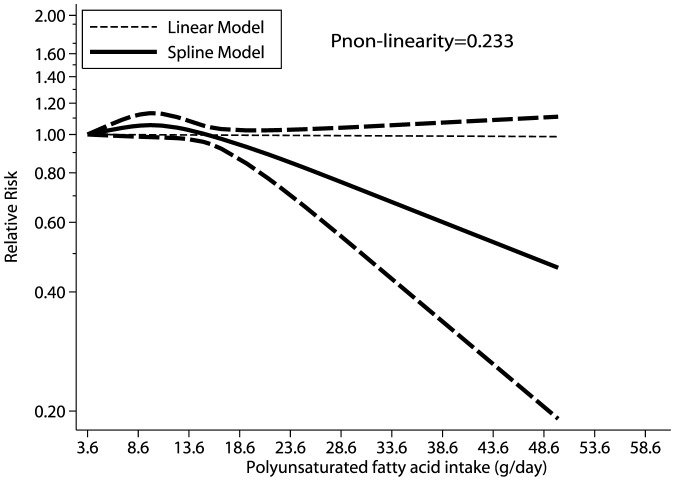
Dose-response relations between PUFA intake and relative risks of lung cancer.